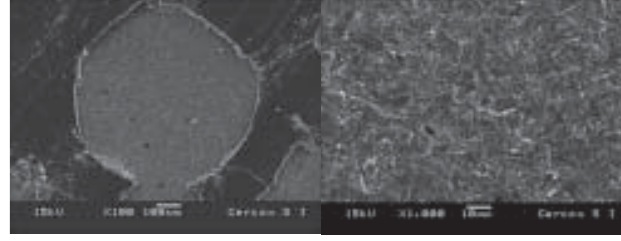
Fig 5. (a) SEM of Cercon: Adhesive fracture pattern (arrow) (A- Original magnification X 100; B- Original magnification X